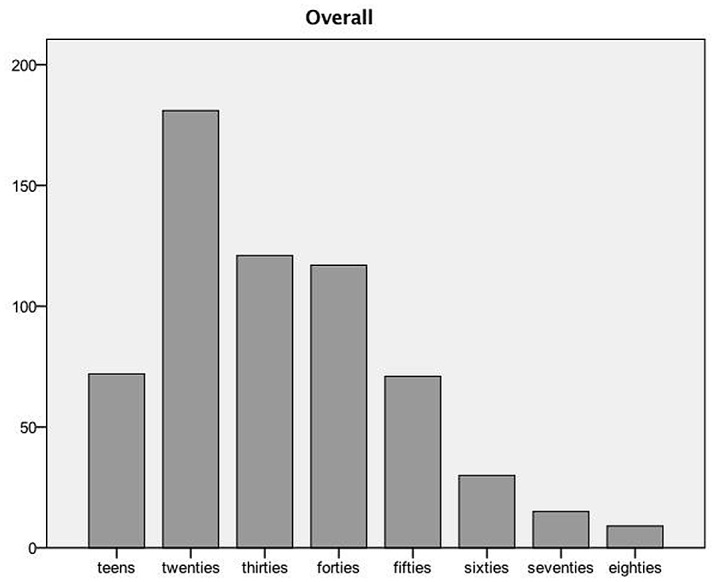
Age distribution.